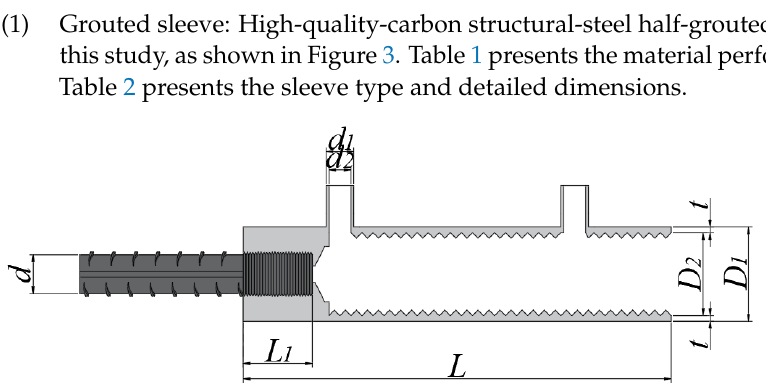
Figure 3. Axial profile of half-grouted sleeve.